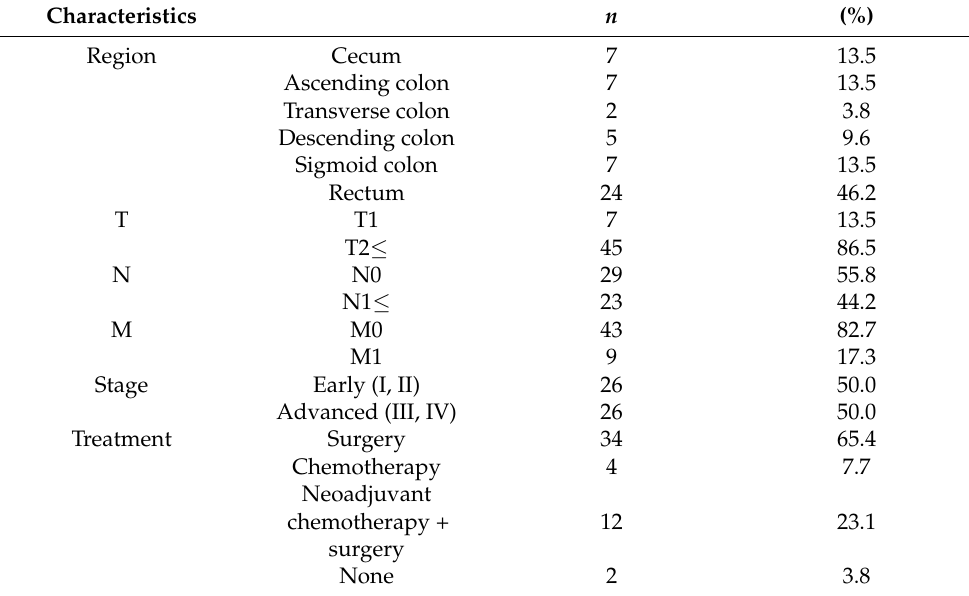
Table 2. Clinicopathological characteristics of CRC